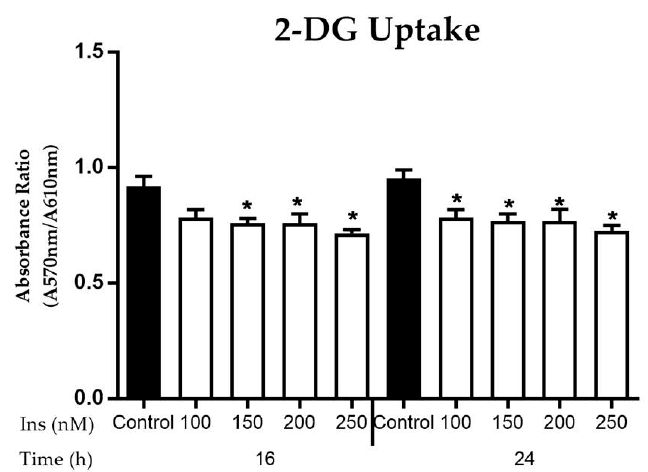
Figure 4. E ff ects of insulin exposure at 150–250 nM concentrations on 2-D-Glucose (2-DG) uptake after incubation at 16 and 24 h. The cells were subjected to prolonged exposure at 16 and 24 h with re-challenged for 30 min. The induced groups were compared with the control group (0 nM of insulin). Results were expressed as mean ± SEM of three independent experiments. Significant values were expressed as * p < 0.05 compared to the negative control